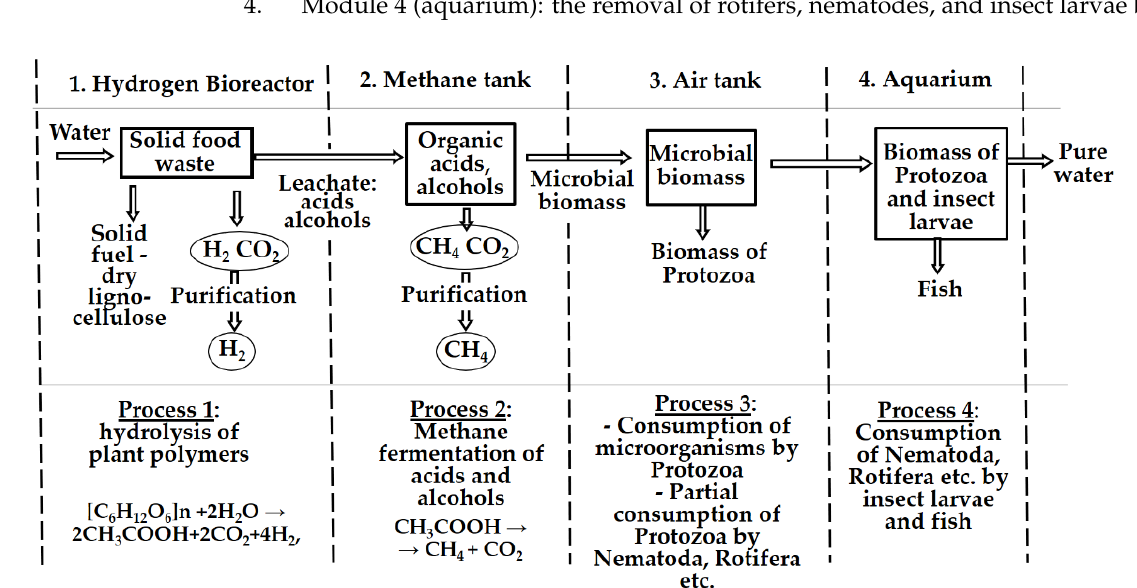
Table 1. Carrier materials used to immobilize microorganisms.